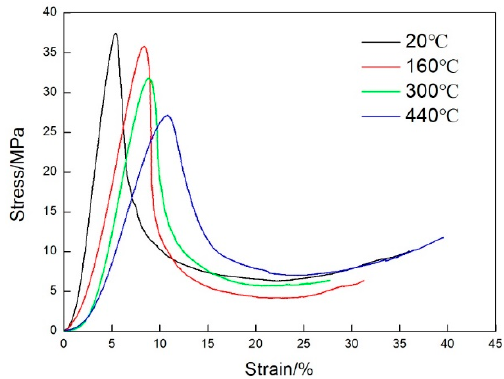
Figure 5. Flatwise compressive stress versus strain curves of vented honeycomb sandwich panels at high temperatures. Table 3. Flatwise compression properties of the vented honeycomb sandwich panels.